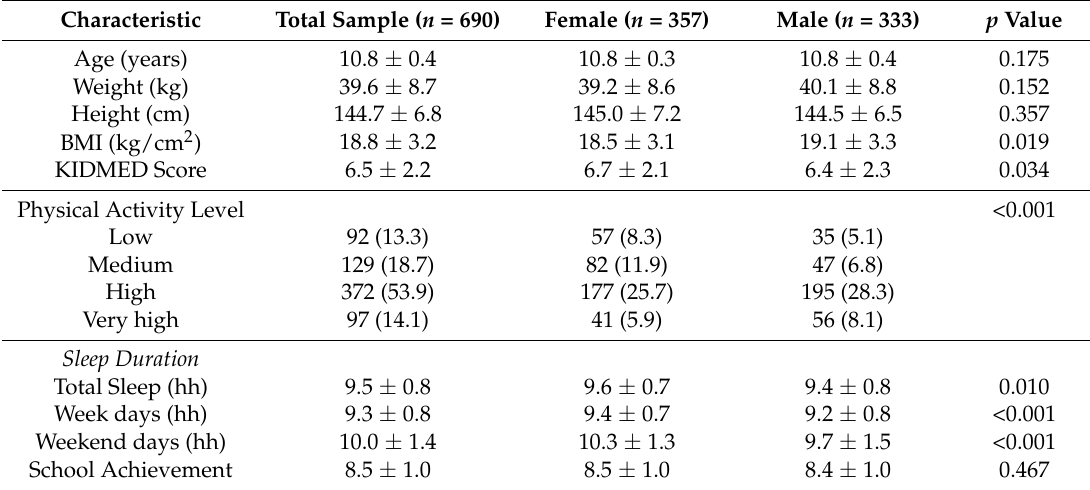
Table 1. Participant characteristics (total sample and by